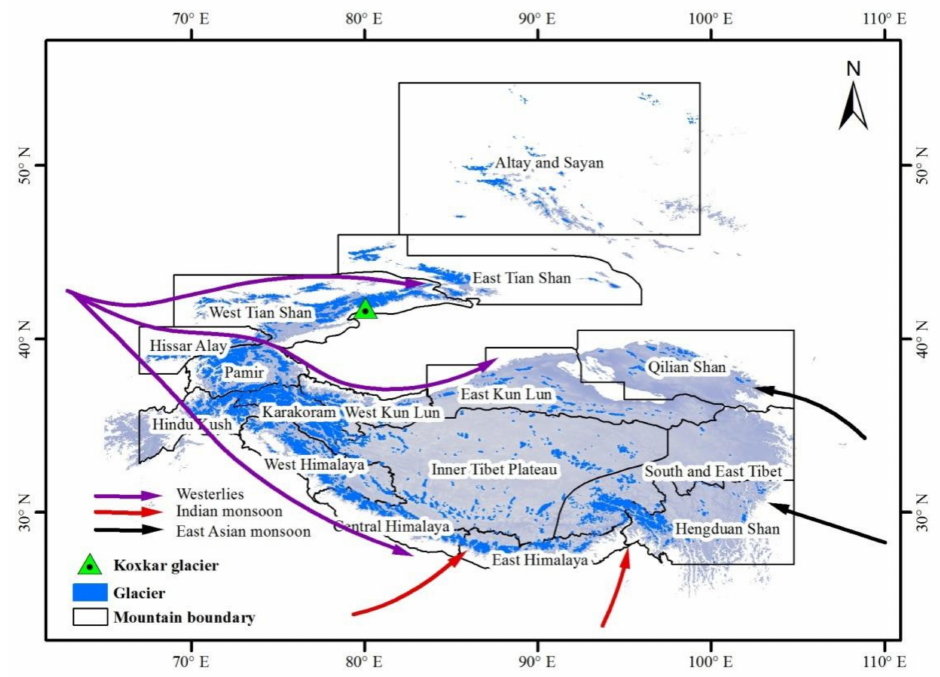
Figure 1. Glacier distribution and regional boundaries within HMA. The grey areas indicate eleva- tions greater than 2800